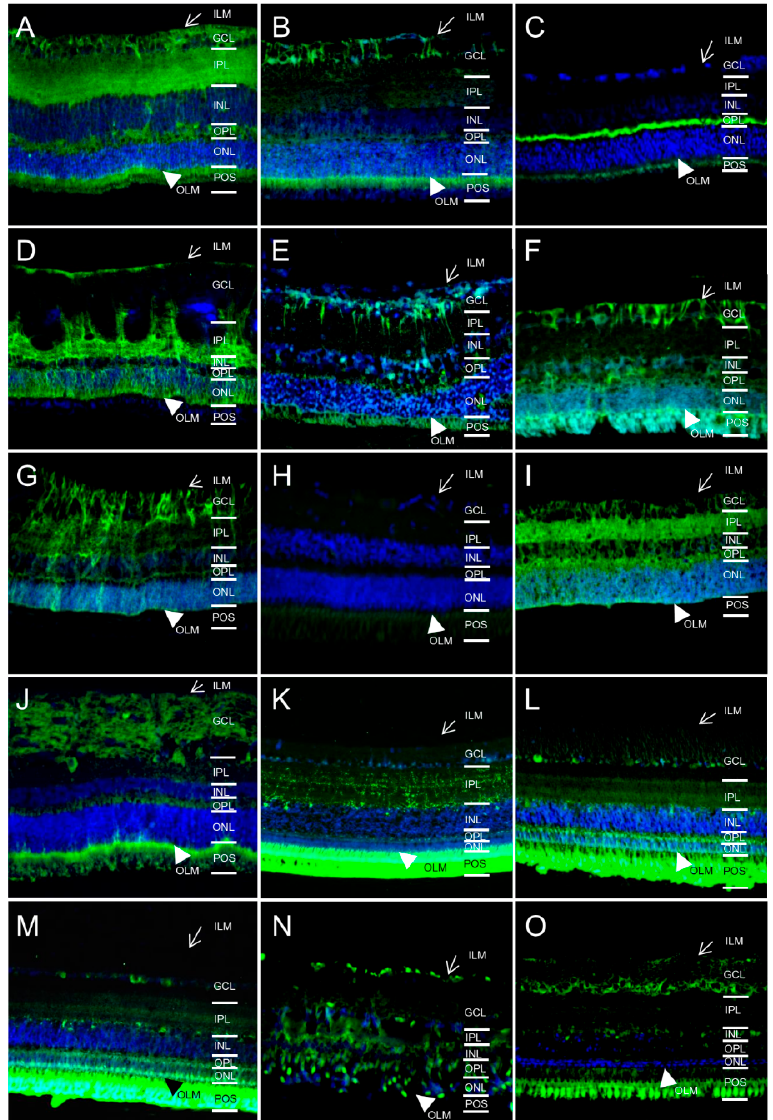
Figure 2. Diverse distribution of AQP5 (green) in retinas of different species (magnification ×40). ILM, inner limiting membrane (arrow); GCL, ganglion cell layer; IPL, inner plexiform layer; INL, inner nuclear layer; OPL, outer plexiform layer; ONL, outer nuclear layer; OLM, outer limiting membrane (arrowhead); POS, photoreceptor outer segments. ( A ) mouse; ( B ) rat; ( C ) guinea pig; ( D ) horse; ( E ) cow; ( F ) sheep; ( G ) deer; ( H ) pig; ( I ) cat; ( J ) dog; ( K ) pigeon; ( L ) chicken; ( M ) pheasant; ( N ) sturgeon; ( O ) char. Cell nuclei: blue (DAPI).